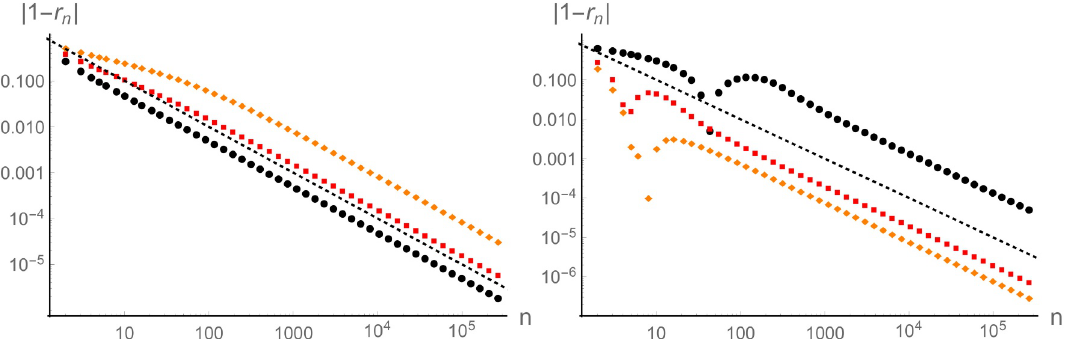
Figure 13 . Deviation ratio (E.6) between the exact a n ( t, 0) coefficients and the large-order pre- diction of the saddle point analysis, for Gaussian initial data with s = 1 . Left: t = 0 . 25 (black), t = 0 . 5 (red), t = 0 . 75 (orange). Right: t = 1 . 25 (black), t = 3 (red), t = 5 (orange). The dotted black line is a plot of the function 1 /n to guide the reader’s